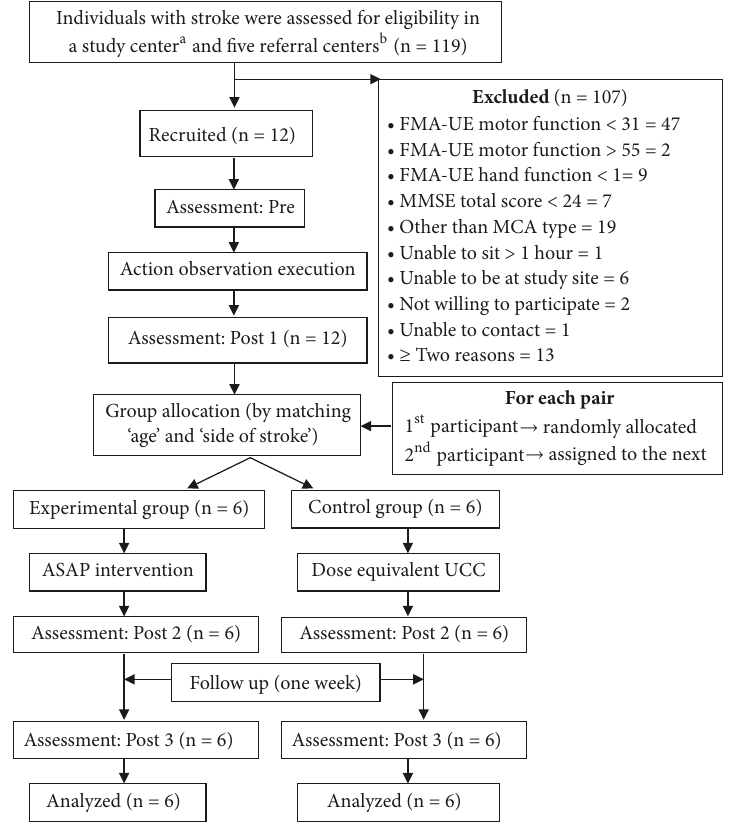
Figure 1: Consort flow diagram. ASAP: accelerated skill acquisition program, UCC: usual and customary care, n: number of participants, FMA-UE: Fugl-Meyer assessment-upper extremity, MMSE: mini-mental state examination, MCA: middle cerebral artery; Kathmandu